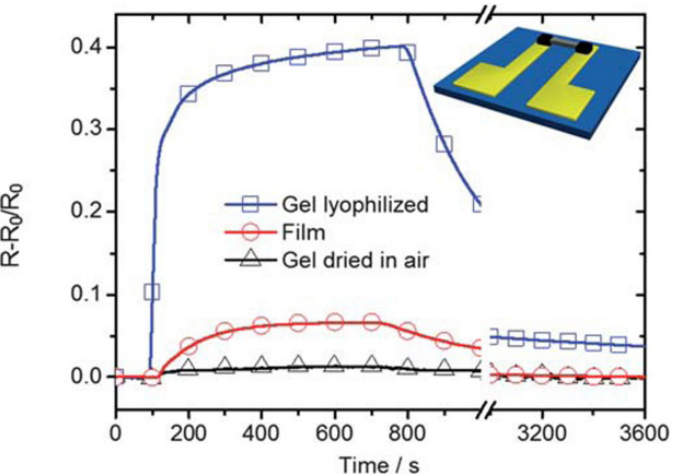
Figure 7. Ammonia gas sensing performance of three devices with sensing elements of lyophilized GO/PPy hydrogel, electrochemically deposited PPy film and GO/PPy hydrogel dried in air. Inset is a sketch of the gas sensor devices. Reprinted with permission from Ref. [138]. Copyright, 2011, Royal Society of